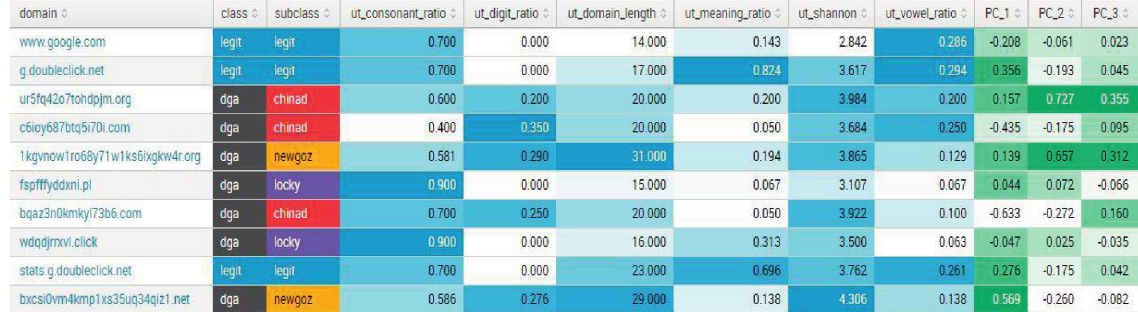
Figure 8: Domain dataset enriched with